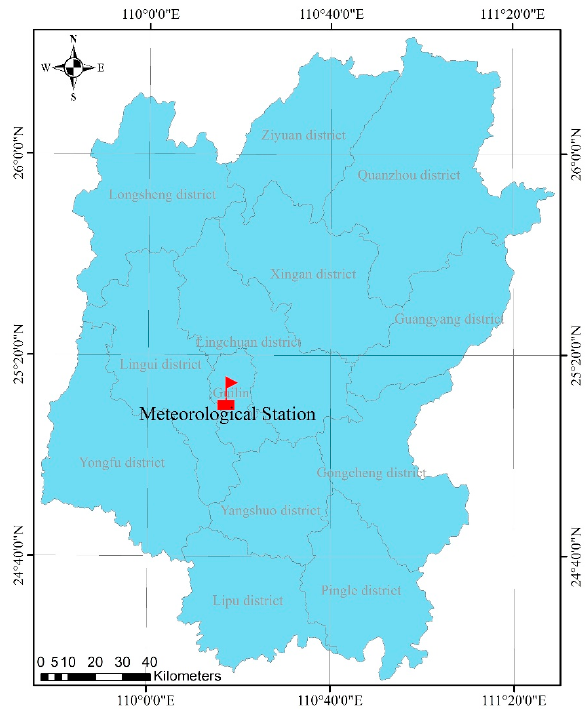
Figure 4. Coordinate location map of the Guilin Monitoring station.